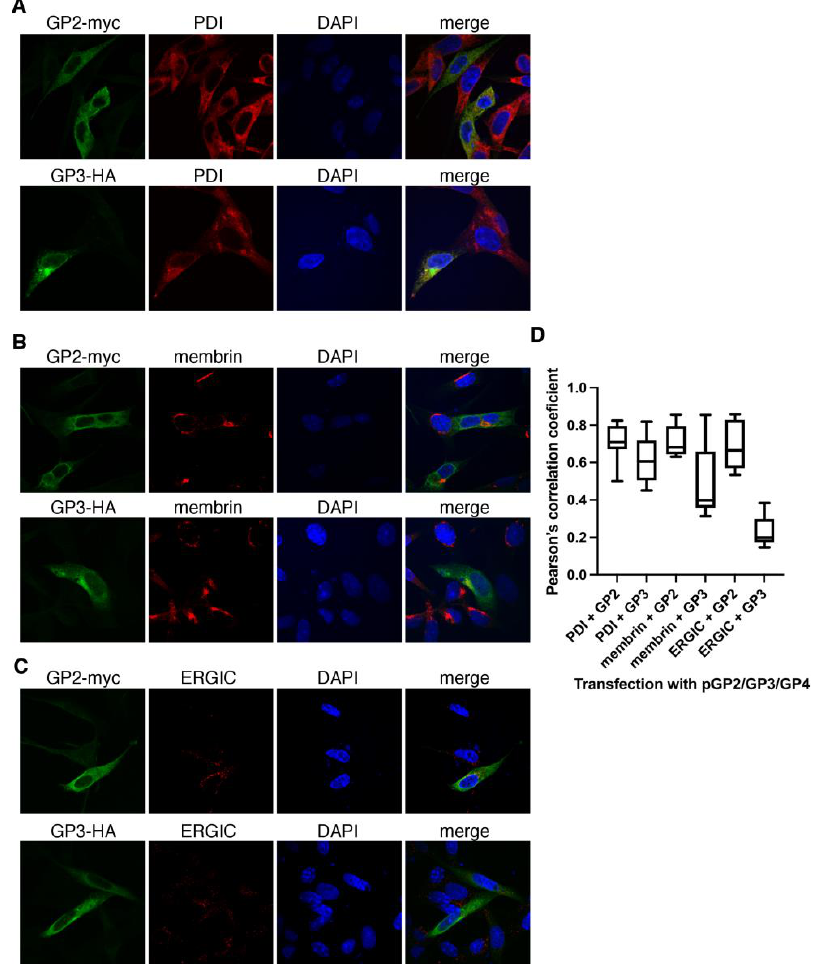
(Figure 7A,B), and the lowest for the ERGIC compartment marker (MOC = 0.41 ± 0.08; PCC = 0.23 ± 0.08) (Figure 7C).